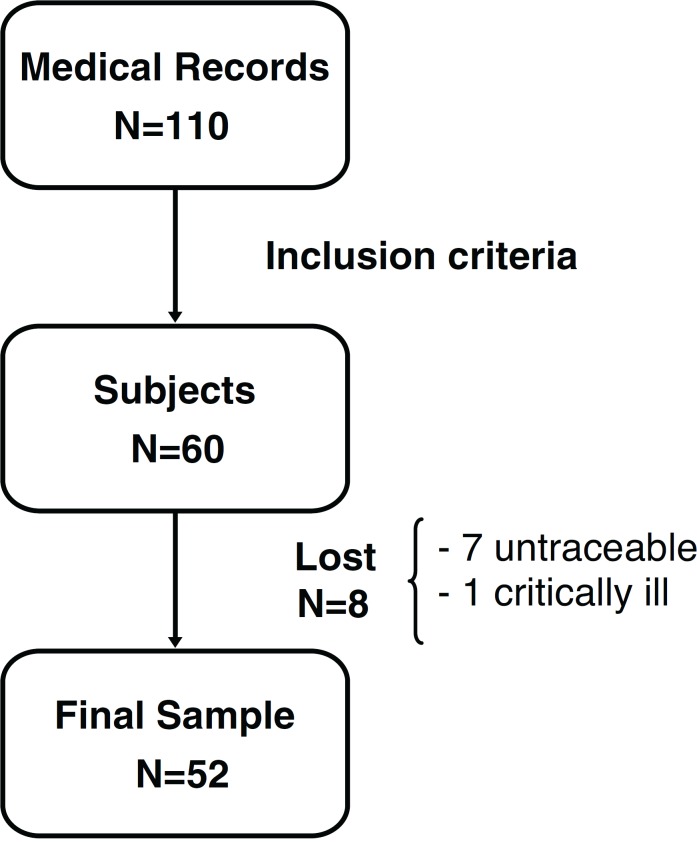
Sample construction.